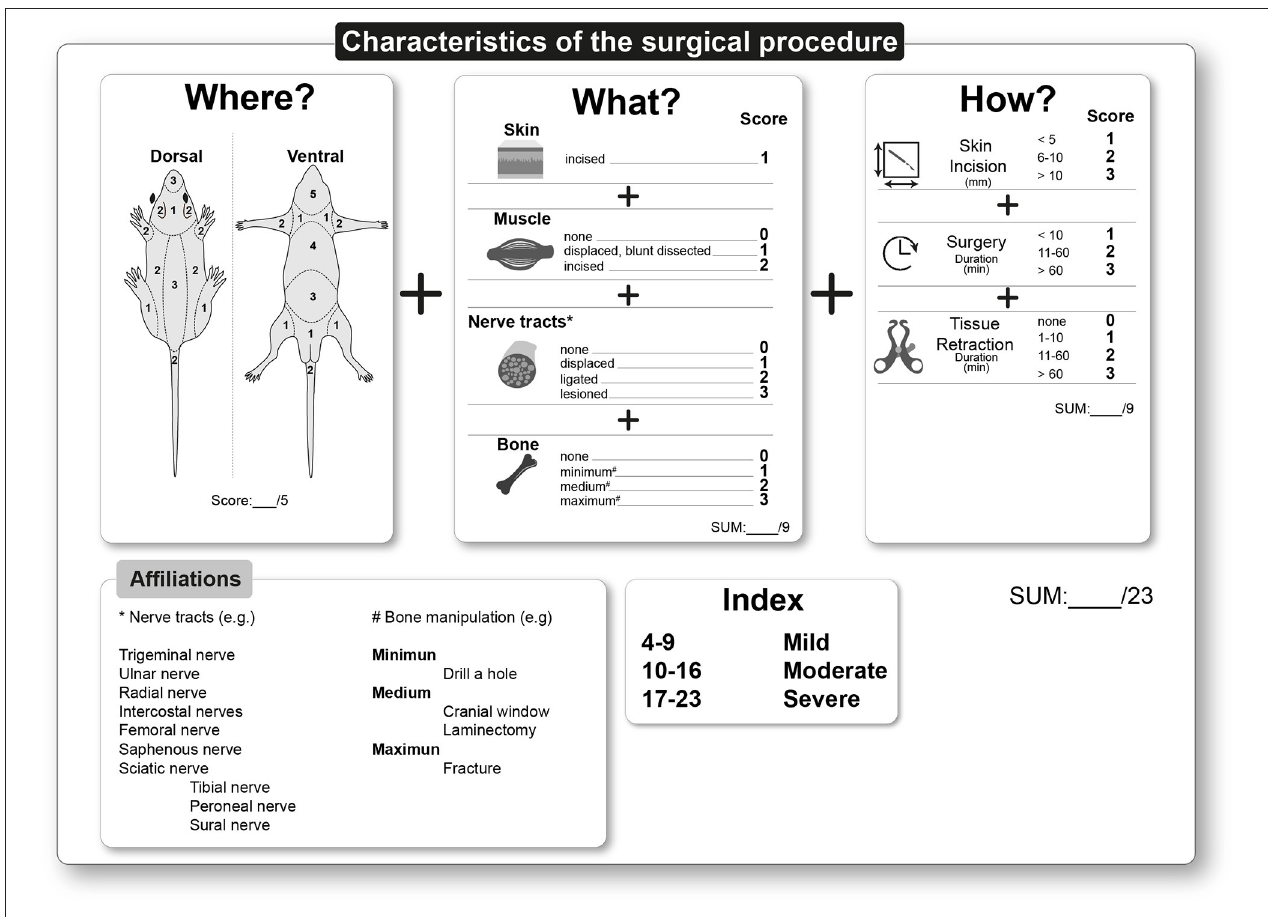
FIGURE 2 | Classification chart for the prospective severity assessment for surgical procedures based on the WWHow concept. The surgical intervention is characterized in terms of “Where”, “What” and “How” and the corresponding scoring. The points are summed and calculated into a total score for the surgical intervention. The minimum score is 4; the maximum is 23. Procedures leading to a score between 4 and 9 result as mild, between 10 and 16 as moderate, and 17–23 points indicate a severe prospective severity assessment of the surgical procedure. (The illustration (“Where”) was created by modifying images purchased in the PPT Drawing Toolkits-BIOLOGY Bundle from Motifolio,